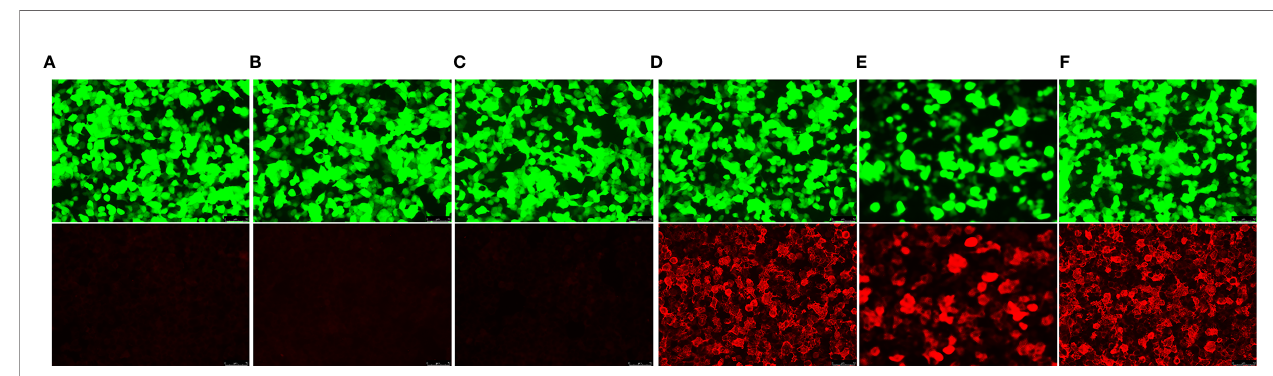
FIGURE 3 | Series anti-thrombospondin type-1 domain-containing 7A (THSD7A) antibody tests. THSD7A IgG detected in the serum using cell-based indirect immuno fl uorescence test. Images on the top show transfection cells express green fl uorescent protein. The images on the bottom show transfected cells with the red fl uorescent-labeled secondary antibody on detection of anti-THSD7A IgG. (A) Negative control. (B) Baseline before treatment (June 19, 2019). (C) After four cycles of induced treatment (September 20, 2019). (D) After four cycles of maintenance therapy (December 12, 2019). (E) At nephrotic syndrome diagnosis (May 12, 2020). (F)